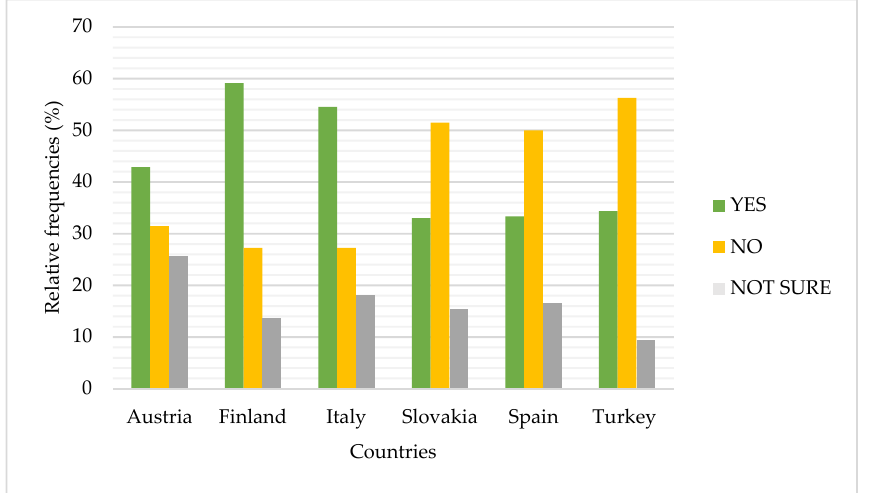
Figure 2. The data visualisation about awareness of the SDGs, according to participating countries (own elaboration, 2021).